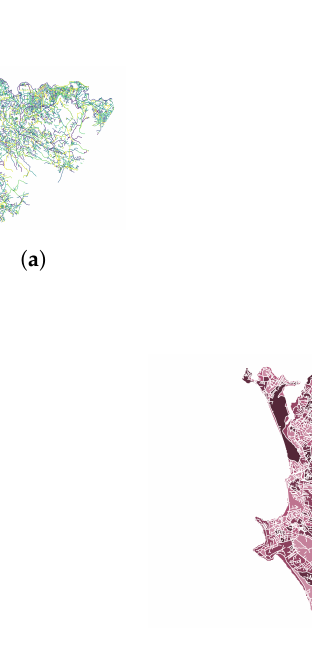
Figure 2. City block extraction. ( a ) The set of streets for an administrative unit, formatted originally as individual LineString s (shown here in varying colors for distinction), comprising a regional street network. ( b ) The union of individual streets (which results in a MultiLineString object), buffered by a small amount to create a MultiPolygon (shown here with an exaggerated buffer). ( c ) The difference between administrative unit boundary and the road network geometry gives the geometric description of street blocks. Colors distinguish between adjacent street blocks. All subfigures show the street network and block geometries for Freetown, Sierra